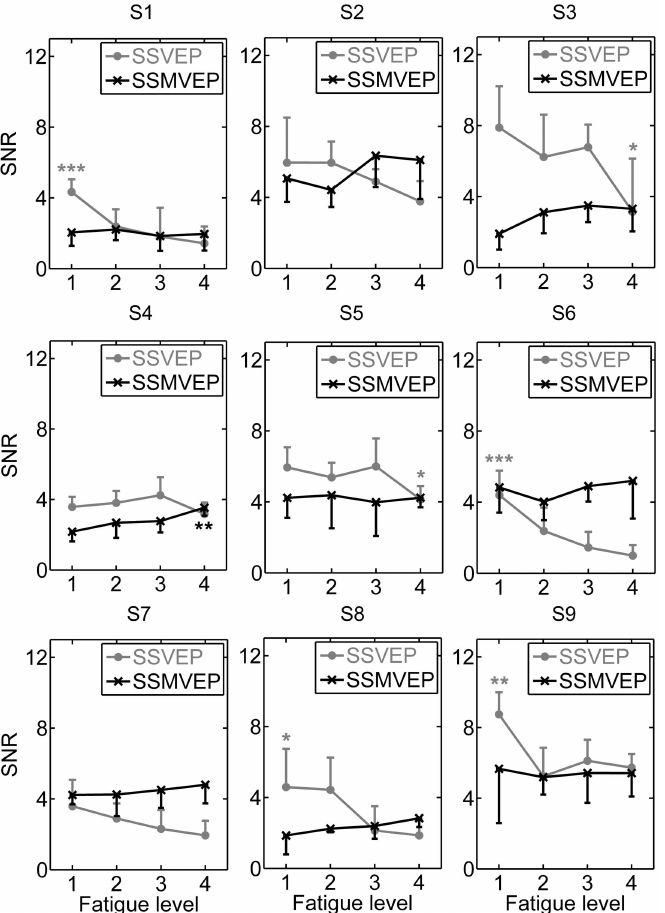
Fig 5. Comparison of SSVEP and SSMVEP SNRs between four different fatigue levels for individual subjects. All statistics were assessed by one-way ANOVA, *** p < 0.001 between four different fatigue levels in both of SSVEP-BCI and SSMVEP-BCI tasks, ** p < 0.01 between four different fatigue levels, * p < 0.05 between four different fatigue